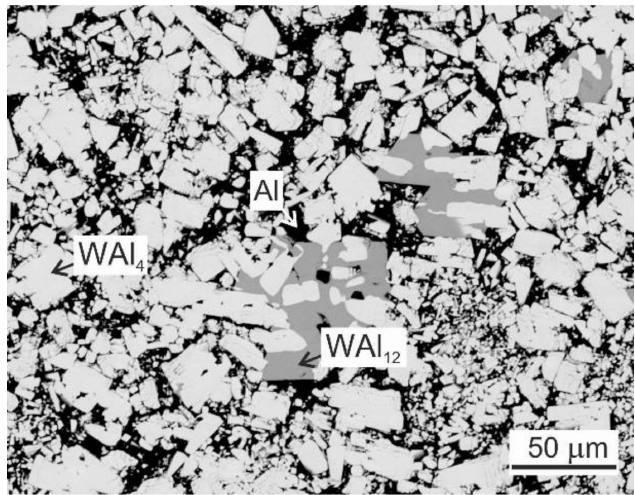
Figure 1. BSE micrograph of the microstructure of master 15W-85Al (at.%) alloy.